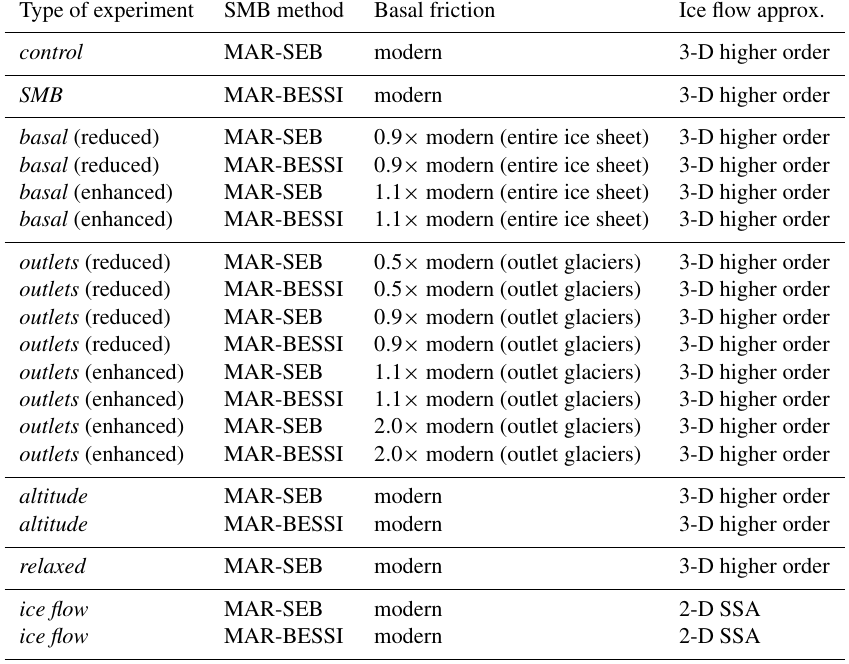
Table 2. Overview of the